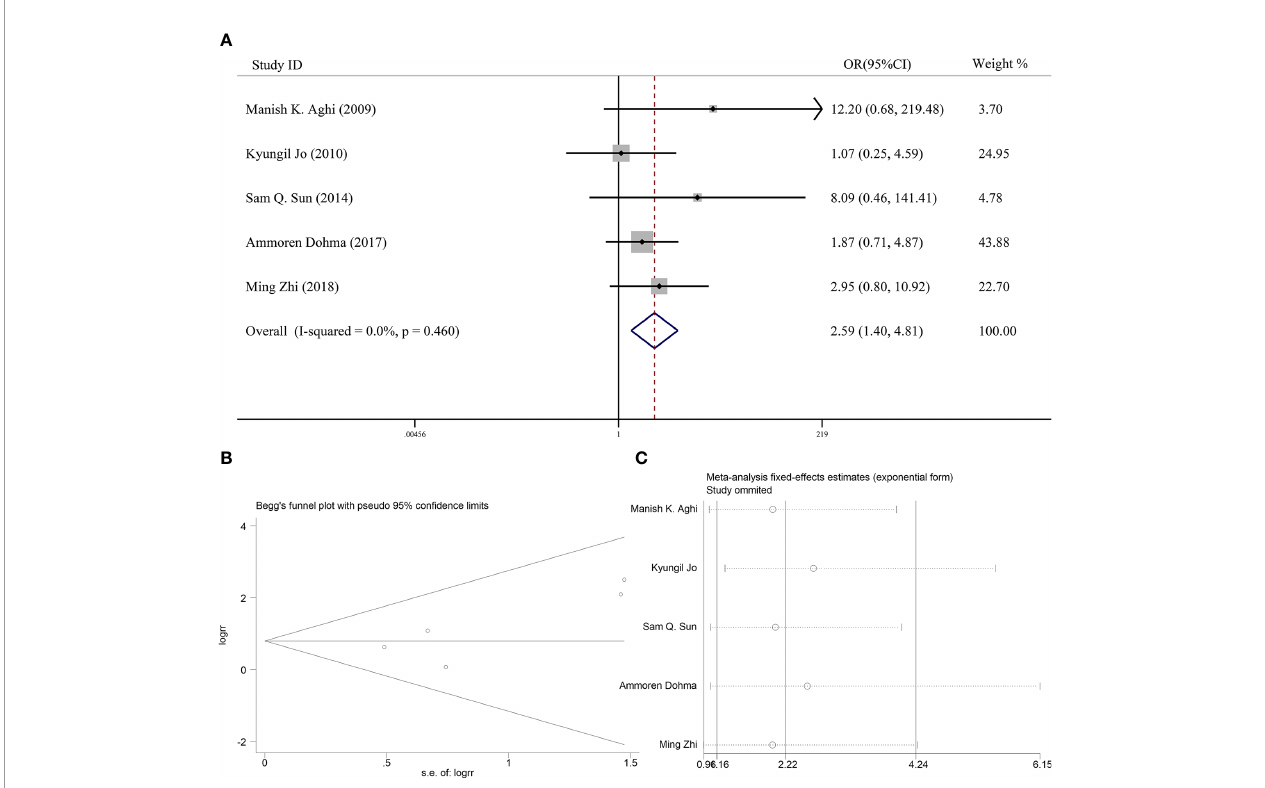
FIGURE 5 | (A) Forest plot for the relationships between PORT and 5-year LC after excluding. (B) Begg ’ s funnel plots of publication bias for meta-analysis of PORT. (C) Sensitivity analysis for meta-analysis of